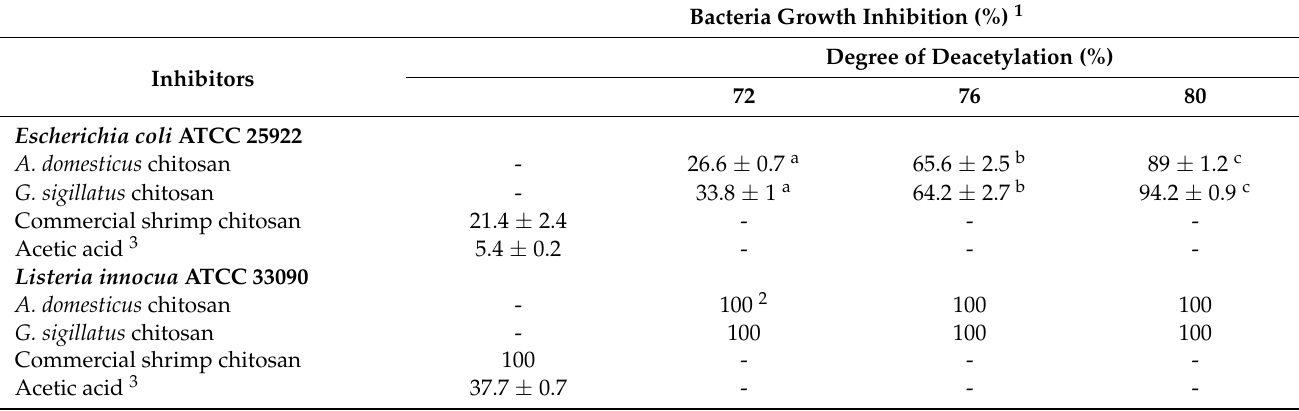
inhibition in chitosan samples inoculated with L. innocua, where no change in optical density at 620 nm was observed (Figure 3, left); 3 acetic acid (0.06% v / v final concentration) quantifies the contribution of solvent to chitosan’s antimicrobial